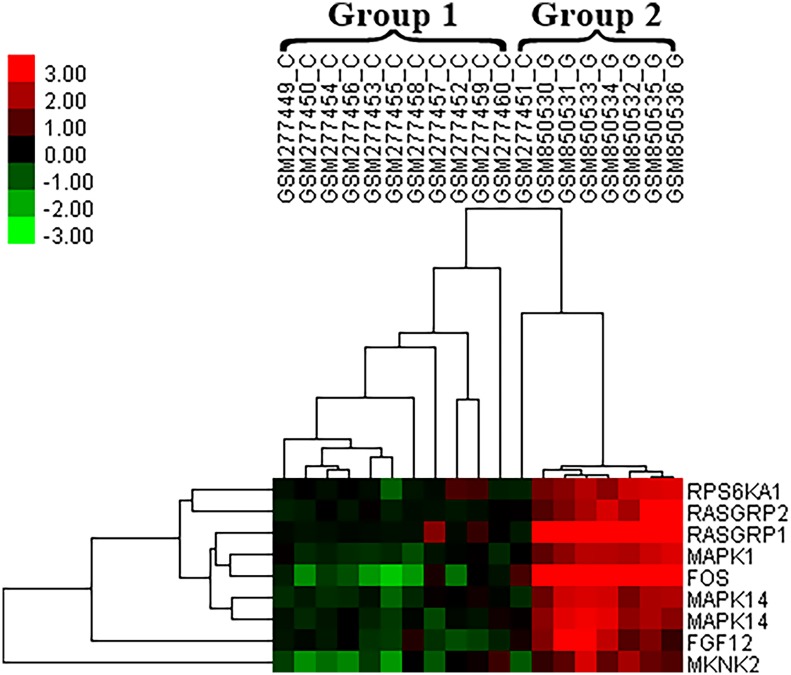
Hierarchical clustering of samples from meta-data and MAPK signaling pathway-related genes, differentially expressed in the meta-analysis study between MGCs and CCs in PCOS group.Cumulus cells were successfully grouped in Group 1, in which expression of MAPK signaling pathway related genes was downregulated.